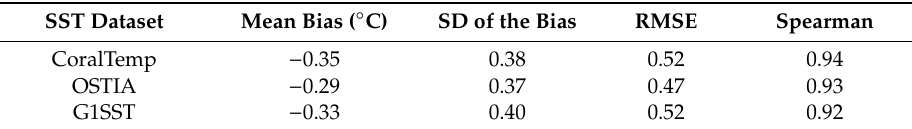
Table 6. Mean bias (satellite—in situ), standard deviation of the bias, root mean square error (RMSE) of the bias, and Spearman correlations between satellite-based SST datasets and averaged in situ temperature for Cayo Enrique and Cayo Mario from 30 June 2017–8 December 2019 (about two years and five months; n = 891 days).